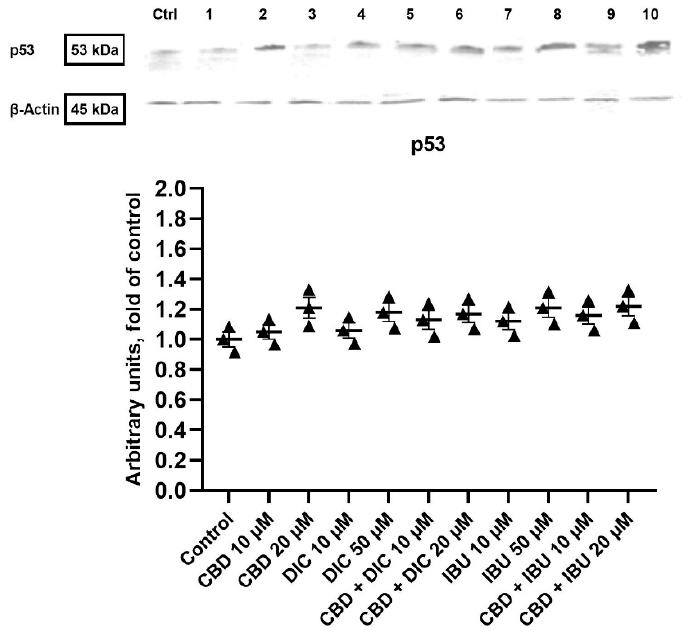
Figure 3. The effect of CBD and its combinations with DIC and IBU on the level of p53 protein in A431 cells. Representative Western blots are presented above the graph. The numerical code follows the order of compounds presented in charts, i.e., Ctrl —Control, 1 —CBD 10 µM, 2 —CBD 20 µM, 3 —DIC 10, 4 DIC—50 µM, 5 —CBD + DIC 10 µM, 6 —CBC + DIC 20 µM, 7 —IBU 10 µM, 8 —IBU 50 µM,